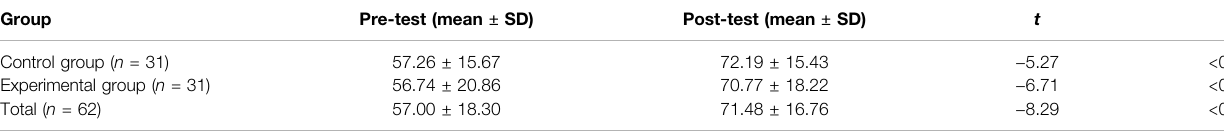
TABLE 2 | The comparison table of pre-test and post-test data. Group